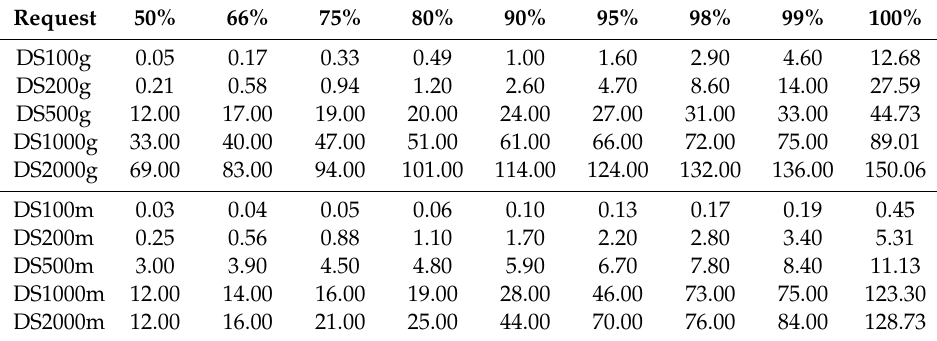
Table 14. Percentage of describeSensor requests completed within given times (in seconds) for the di ff erent configuration of concurrent users and WSGI server (case